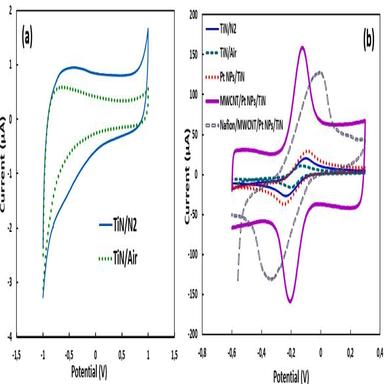
(a) Water windows for TiN/N2 and TiN/Air electrodes. (b) CV voltammograms obtained with TiN/N2, TiN/Air, Pt NPs/TiN, MWCNTs/Pt NPs/TiN, Nafion/ MWCNTs/Pt NPs/TiN electrodes. All in 0.1 M KCl solution containing 1 mM Ru (NH3)6 2+/3+at a scan rate of 50 mV/s.